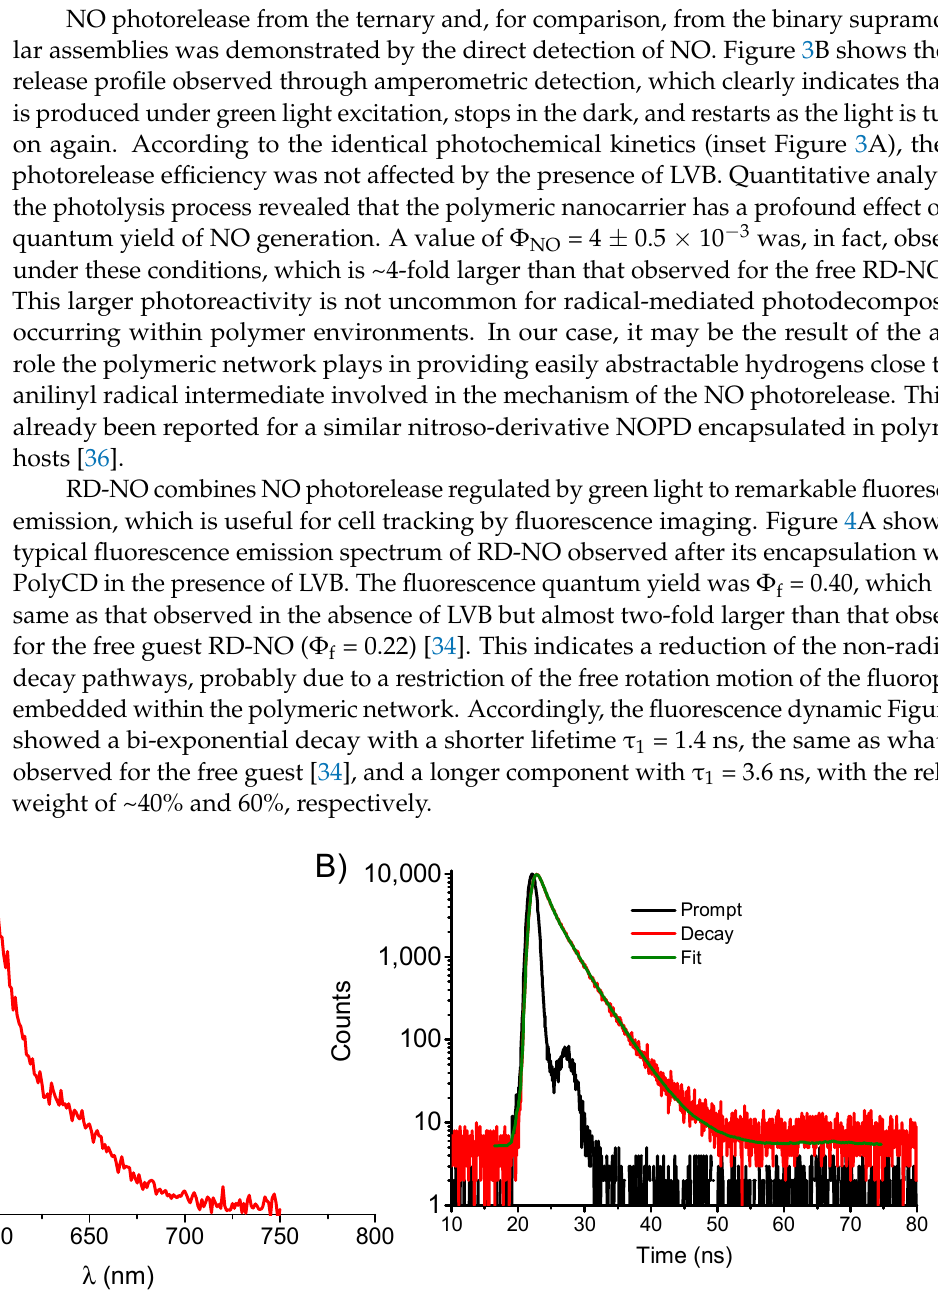
Figure 4. ( A ) Fluorescence emission spectrum observed at λ exc = 520 nm light excitation for a PBS (pH 7.4) solution of PolyCD (2 mg mL − 1 ) co-loaded with LVB (25 µM) and RD-NO (6 µM). ( B ) Fluorescence decay and the related fitting of the same solution recorded at λ exc = 455 nm and λ em = 590 nm. T = 25 °C.